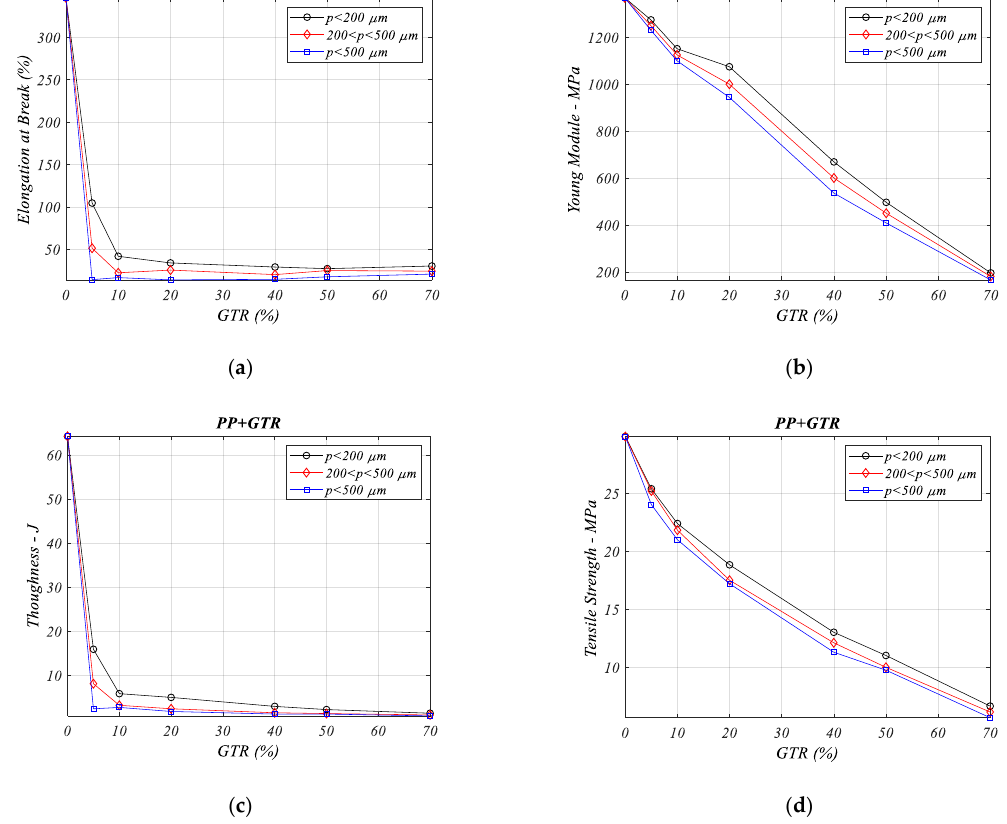
Figure 3. Mechanical properties analysis for some percentage of PP/GTR composites and particle sizes: ( a ) elongation at break (%), ( b ) Young ’s modulus (MPa), ( c ) toughness (J) ( d ) tensile stress (MPa).